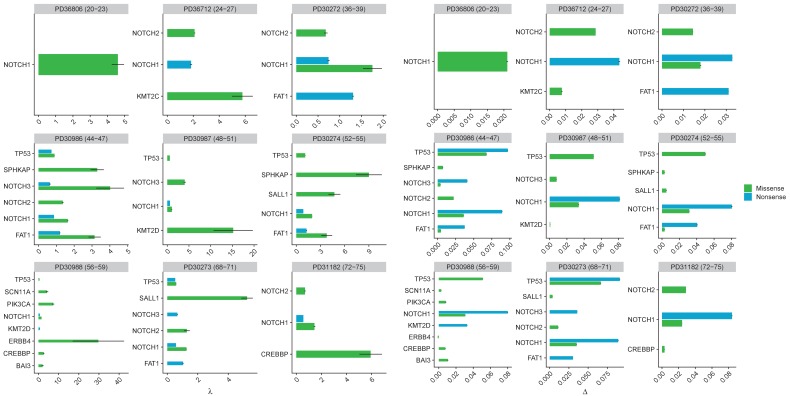
Inferred parameters for each gene in each patient in the oesophagus dataset where there were sufficient mutations to perform the analysis.Left hand plot shows inferred loss replacement rates λ and right hand plot inferred biases ∆.